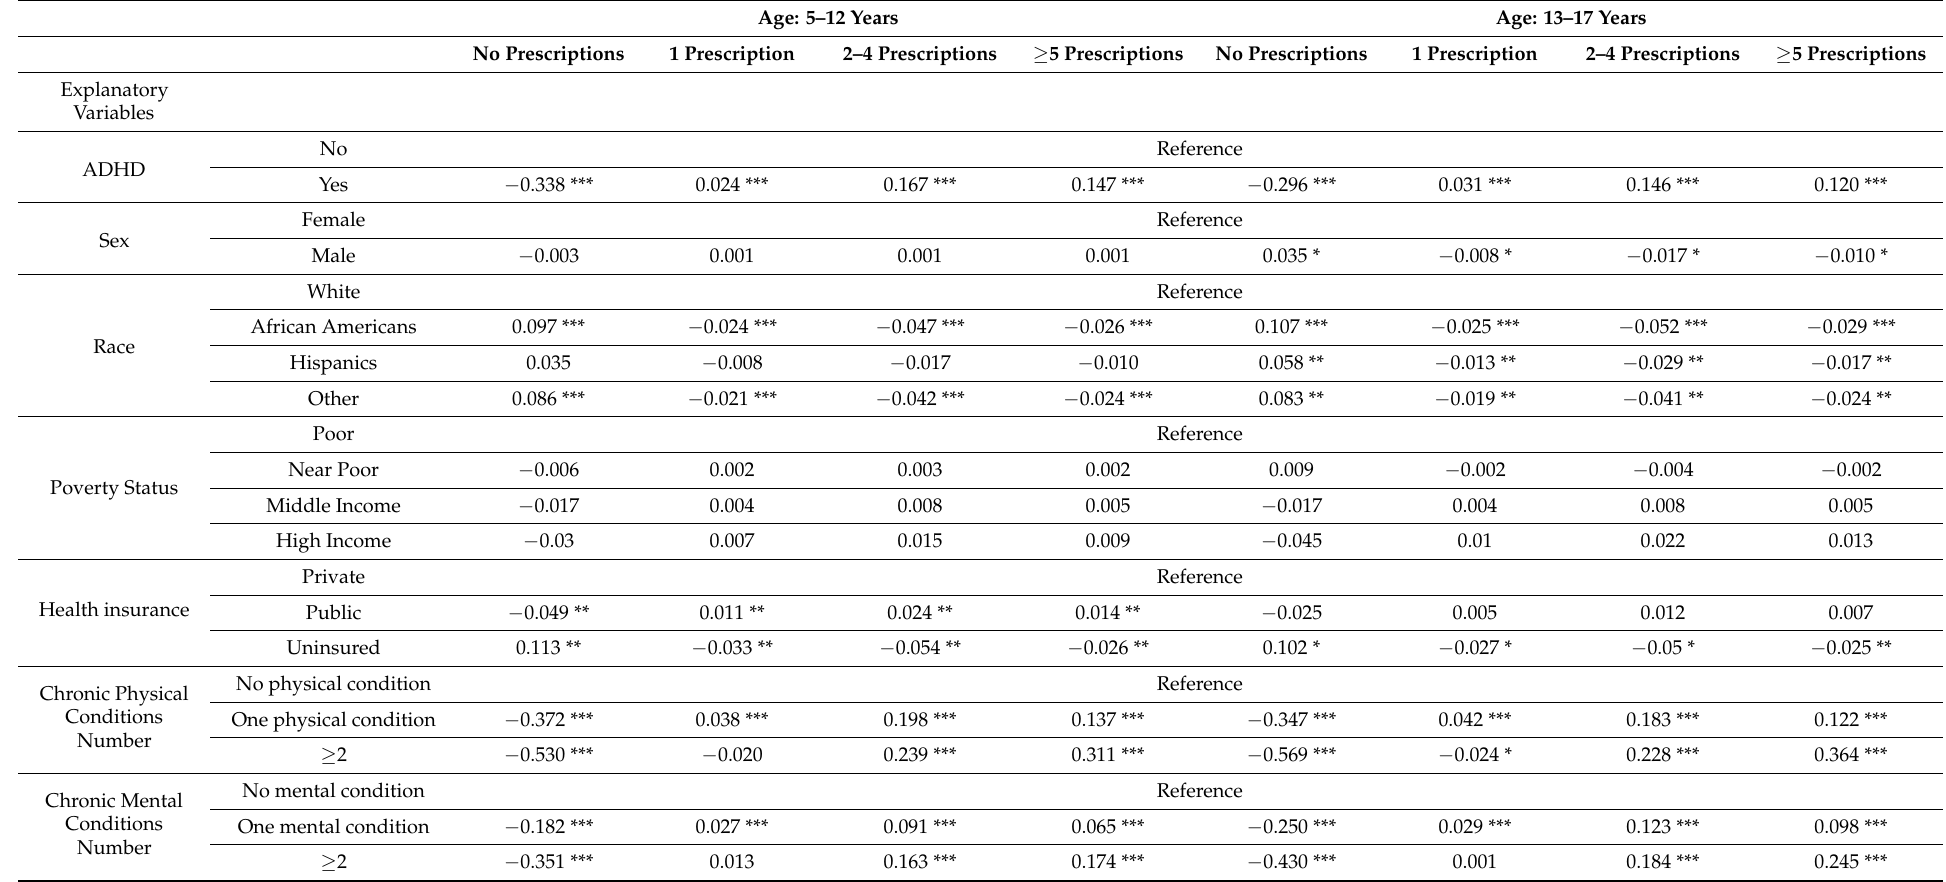
Table 3. Estimated marginal effect of the explanatory variables on number of prescription medications